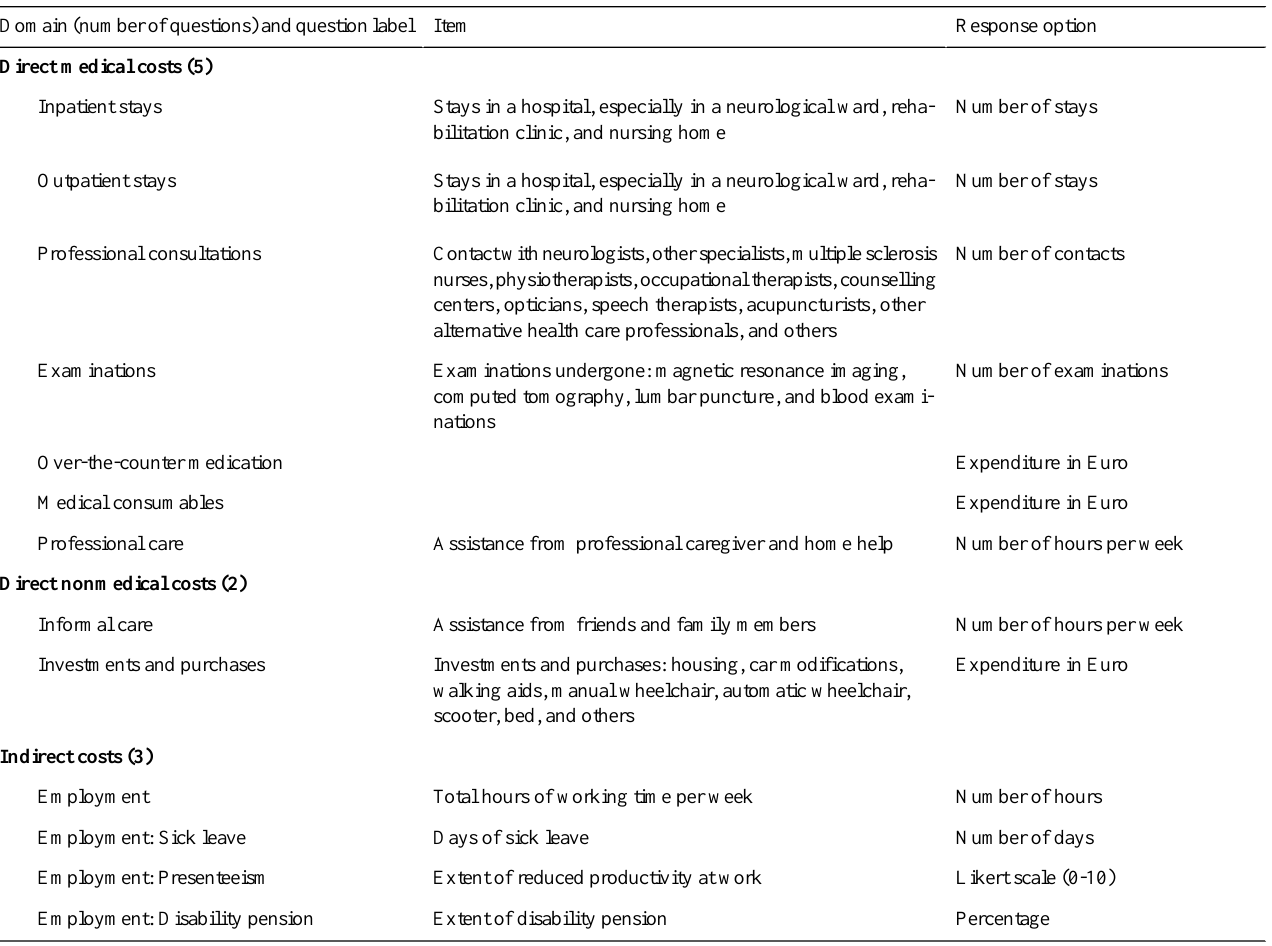
Table 1. Core items of the Multiple Sclerosis Health Resource Utilization Survey: content and response